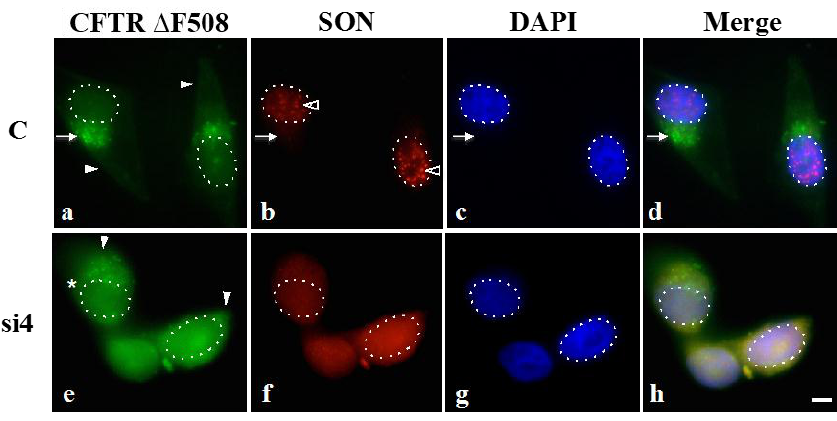
Figure 5. SON depletion reduces HDAC6-mediated aggresome formation. HeLa